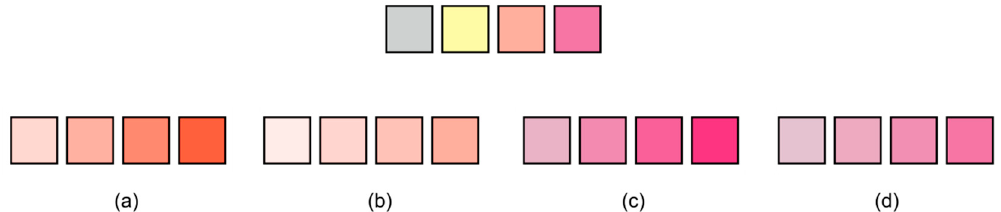
Figure 13. The HERE Maps road network color scheme (top) and replacement suggestions: ( a ) monochromatic color scheme Hue 10, Brightness 100, Saturation from 19 to 75; ( b ) monochromatic color scheme Hue 10, Brightness 100, Saturation from 9 to 39; ( c ) monochromatic color scheme Hue 339, Brightness 86, Saturation from19 to 75; ( d ) monochromatic color scheme Hue 339, Brightness 86, Saturation from 12 to 47.